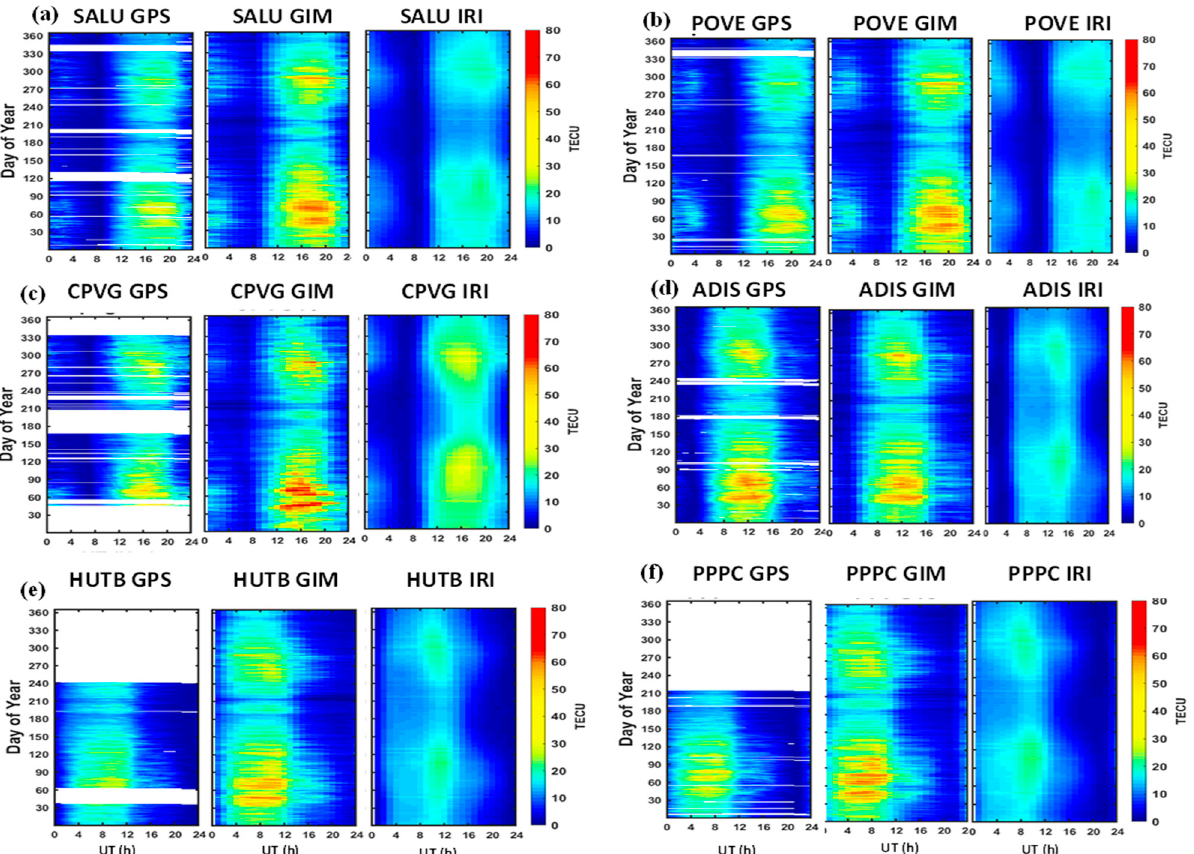
Figure 2. Diurnal variations in GPS-TEC and assessment of GIM and IRI-2016 models at the American (GPS stations: ( a ) SALU and ( b ) POVE), African (GPS stations: ( c ) CPVG and ( d ) ADIS), and Asian (GPS stations: ( e ) HUTB and ( f ) PPPC) longitudes for the year 2016. The details of the GPS stations are mentioned in Table 1.